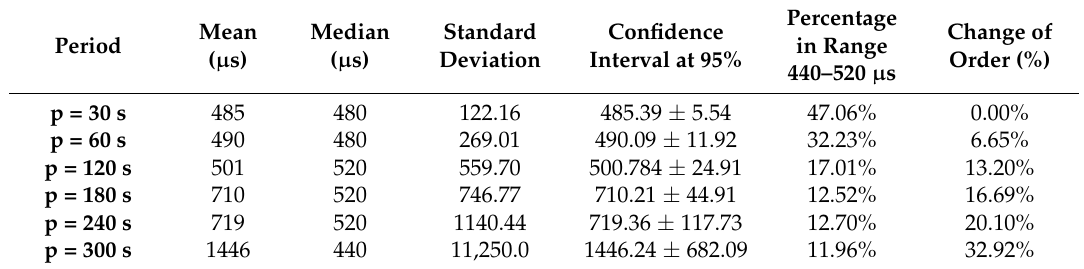
Table 6. Results obtained in the sequence experiment with tradition clock synchronization.